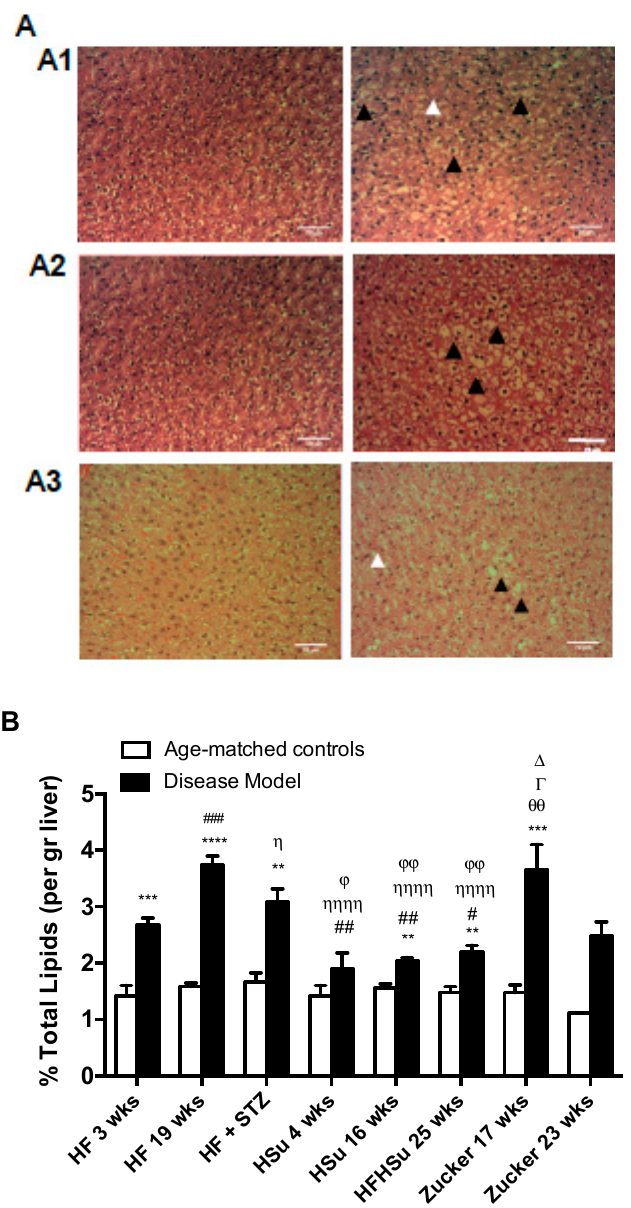
Figure 5. Lipid deposition in the liver in the distinct models of obesity and type 2 diabetes. ( A ) Hematoxicilin and eosin images of liver slices from HF 19 weeks (A1), HFHSu 25 weeks (A2), and Zucker 23 weeks (A3) and their respective controls. ( B ) Percentage of lipid deposition in the liver quantified by the Folch method [26]. All groups of hypercaloric diet animals and its age-matched controls as well as Zucker diabetic rat and its lean controls of 17 weeks included 6–8 animals per group; Zucker diabetic rat of 23 weeks included 3 animals per group, and its lean control only one animal. Bars represent means ± SEM; two-way ANOVA with Bonferroni’s multiple comparisons test: ** p < 0.01, *** p < 0.001, and **** p < 0.0001 comparing age-matched controls with disease models; # p < 0.05, ## p < 0.01, and ### p < 0.001 comparing HF 3 weeks with HF 19 weeks, HSu 4 weeks, and HFHSu 25 weeks; η p < 0.05 and ηηηη p < 0.0001 comparing HF 19 weeks with HF + STZ, HSu 4 weeks, and HFHSu 25 weeks; ϕ p < 0.05, ϕϕ p < 0.01 comparing HF + STZ with HSu 4 weeks and HFHSu 25 weeks; ∆ p < 0.05 comparing HSu 4 weeks with Zucker 17 weeks; Γ p < 0.05 comparing HSu 16 weeks with Zucker 17 weeks; θθ p < 0.01 comparing HFHSu 25 weeks with Zucker 17 weeks. Black arrowheads represent lipidosis and white arrowheads fibrosis. Scale bar, 100 µ m; original magnification, 20 ×